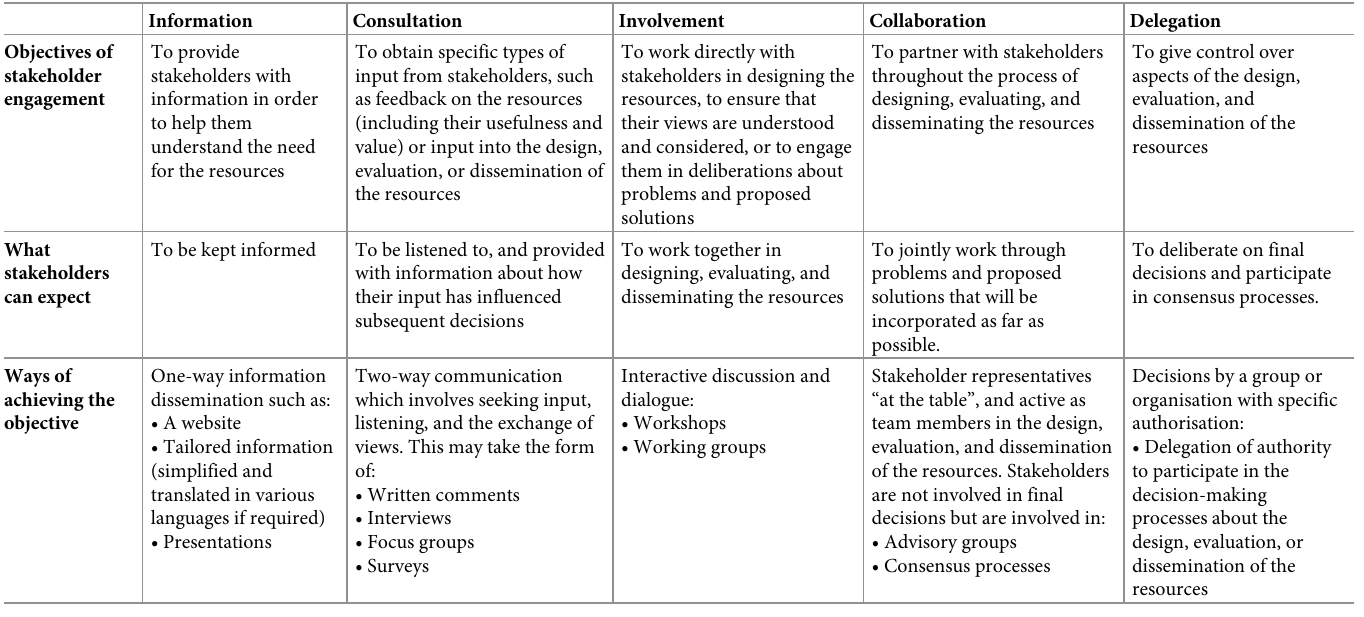
Table 1. Levels of stakeholder engagement in designing, evaluating, and disseminating learning resources �